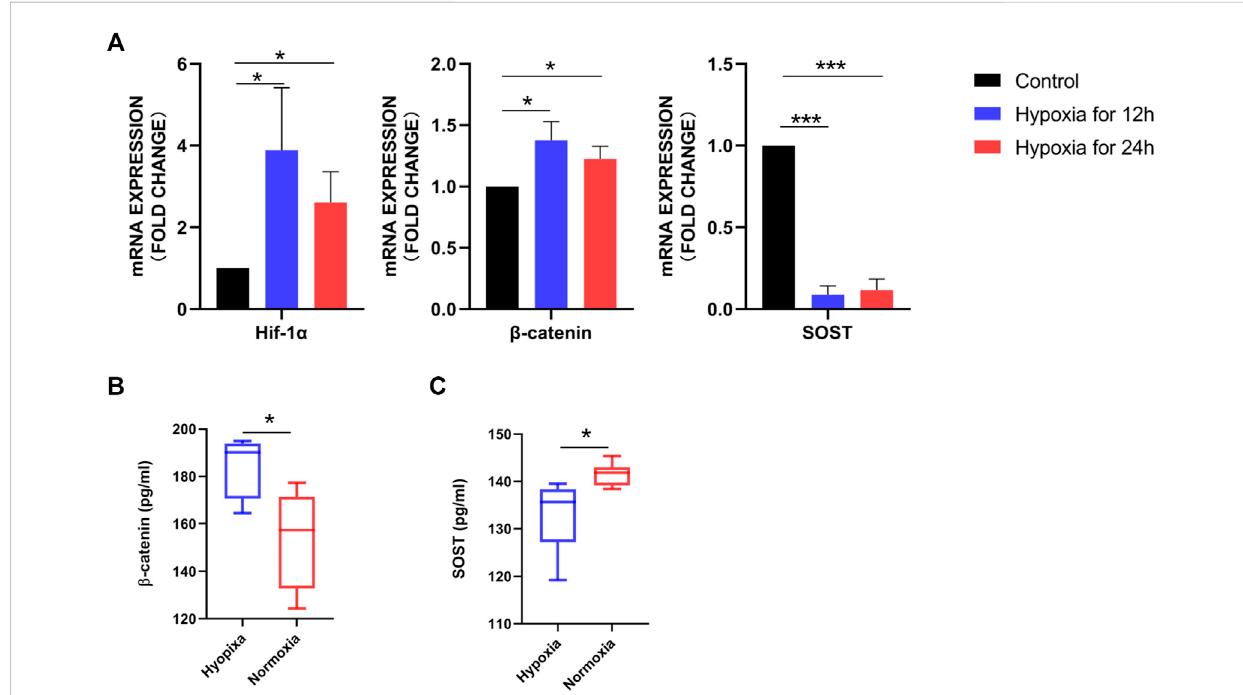
FIGURE 2 Differentially expressed soluble mediators identi fi ed in osteoblasts under hypoxia. (A) RT-PCR analysis of Hif-1 α , β -catenin, and SOST expression. Hif-1 α and β -catenin expression was signi fi cantly higher in osteoblasts cultured under hypoxia for 12 and 24 h than under normoxia for 12 and 24 h. (B) Western blot analysis demonstrating increased β -catenin expression in osteoblasts after 12 h hypoxia, with β -actin as the loading control. (C) β -Catenin and SOST concentrations in the conditioned medium of osteoblasts cultured under hypoxia and normoxia for 12 h detected using